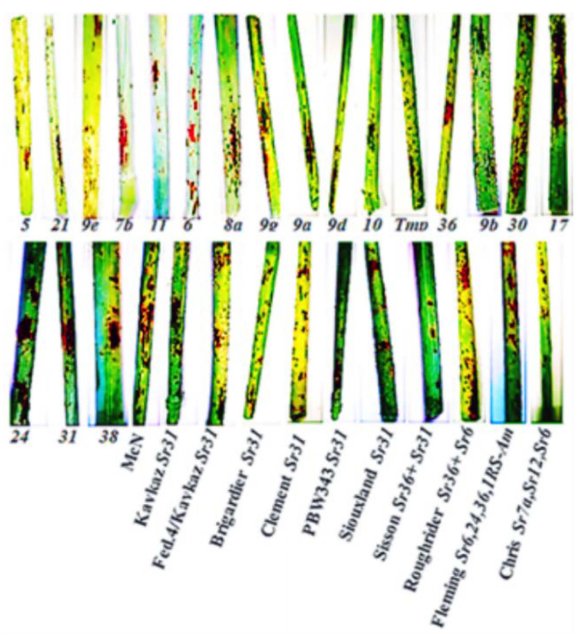
Figure 1. Symptoms of wheat stem rust on 30 wheat lines and varieties with stem rust resistance genes ( Sr ) at Sharqia location during the 2021 growing